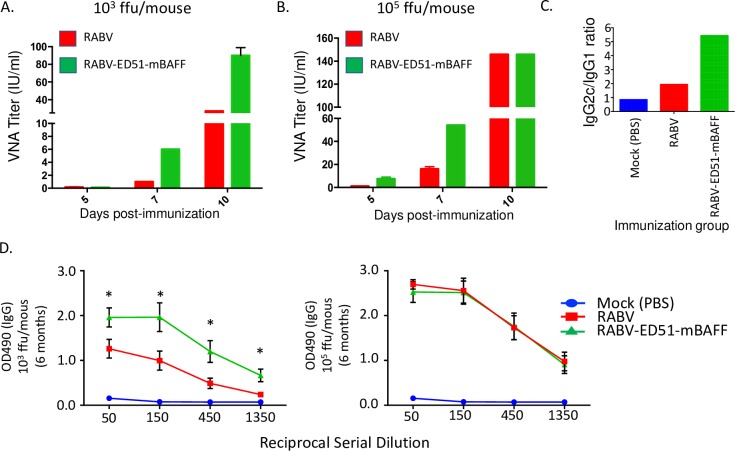
RABV-ED51-mBAFF induces potent VNA titers and a Th1-biased antibody response, which does not adversely affect long term immunity.Sera from mice immunized with 103 (A) or 105 (B) ffu/mouse of RABV-ED51-mBAFF or RABV were pooled and analyzed for VNA titers using RFFIT. Data represents sera from 5 mice per group pooled in two assays (N = 10/group) and completed in duplicate. International Units (IU)/ml were determined by comparing results to a WHO standard. Serum from mice immunized with 105 ffu/mouse on day 14 post-immunization were analyzed by ELISA for anti-RABV G IgG1 and IgG2c titers. (C) The ratio of IgG2c/IgG1 is summarized from N = 10 mice per group. (D) Serum from mice immunized with 103 (left) or 105 ffu/mouse (right) 6 months post-immunization were analyzed for total anti-RABV G IgG titers. Statistical difference in antibody titers by ELISA between RABV- and RABV-ED51-mBAFF-immunized mice was determined using an unpaired, two-tailed t test and data is presented as the mean ± SEM. *p≤0.05 (N = 10).